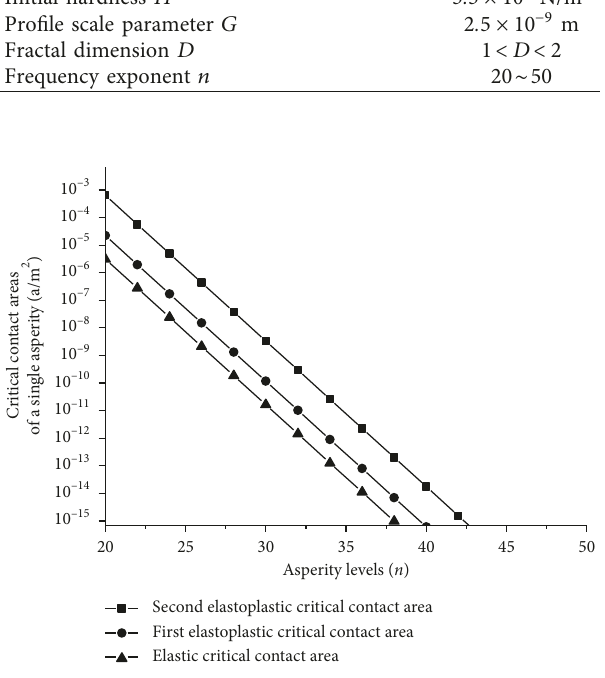
Figure 2: The relationship between critical contact area and fre- quency exponent of a single asperity.